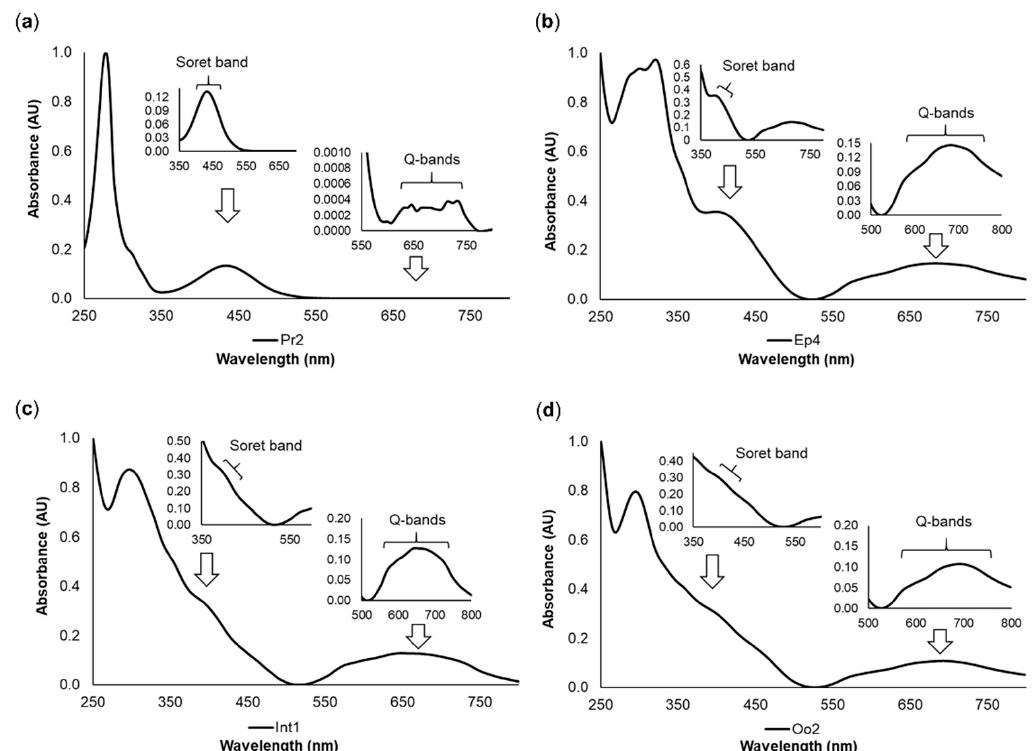
Figure 3. Representative pigment absorption spectra of Eulalia pigments. The data were retrieved using high-performance liquid chromatography with a diode array detector (HPLC-DAD). Each graph displays the Soret band (380–500 nm) and Q bands (500–750 nm) with different degrees of resolution. ( a ) Pr2, a yellow pigment from the proboscis; ( b ) Ep4, a green pigment from the epidermis; ( c ) Int1, a green pigment from the intestine; and ( d ) Oo2, a green pigment from the oocytes. The retention times were 4.05 min for Pr2, 6.63 min for Ep4, 5.47 min for Int1, and 4.89 min for Oo2.